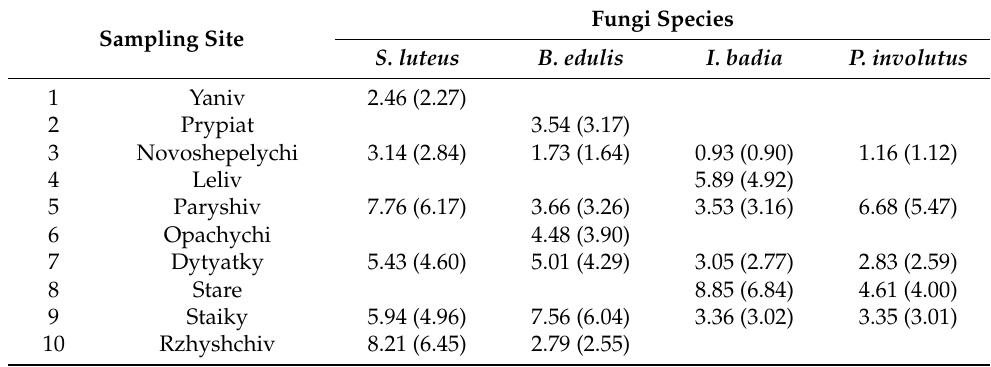
Table 2. T eco and T eff (values in parentheses) in years of 137 Cs in symbiotrophic fungi species.